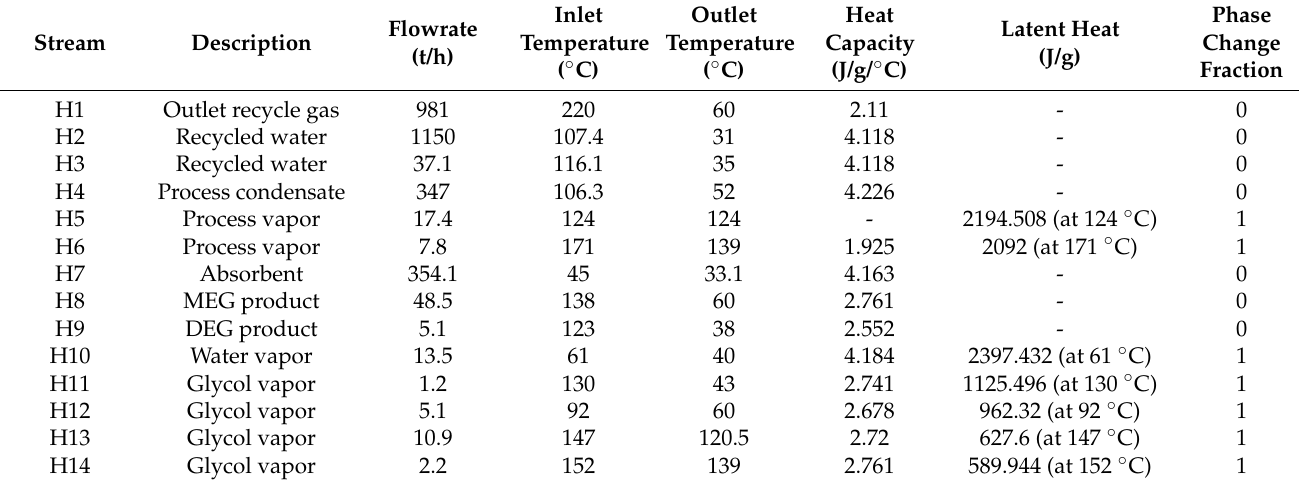
Table 1. Hot process stream data.